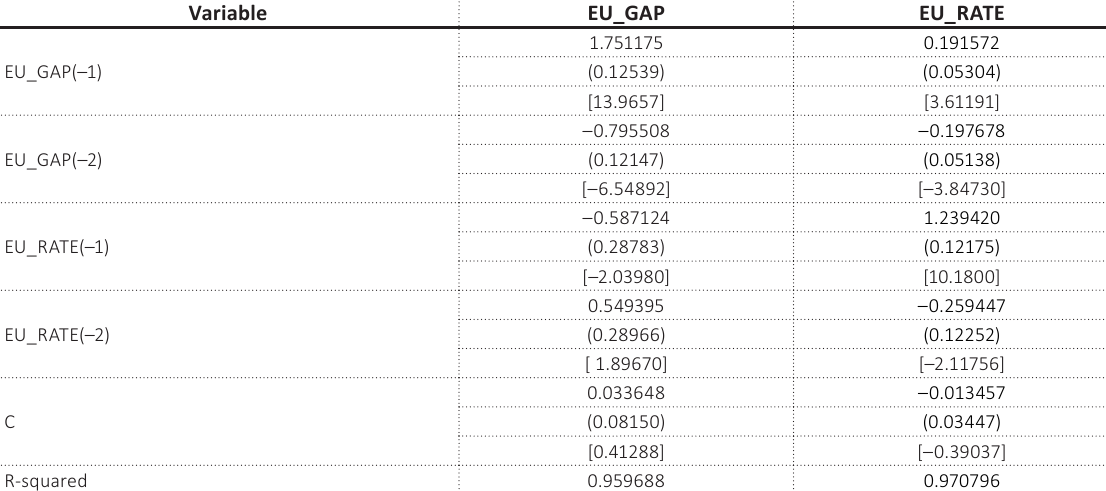
Table A4.1. VAR model assessed for the EU